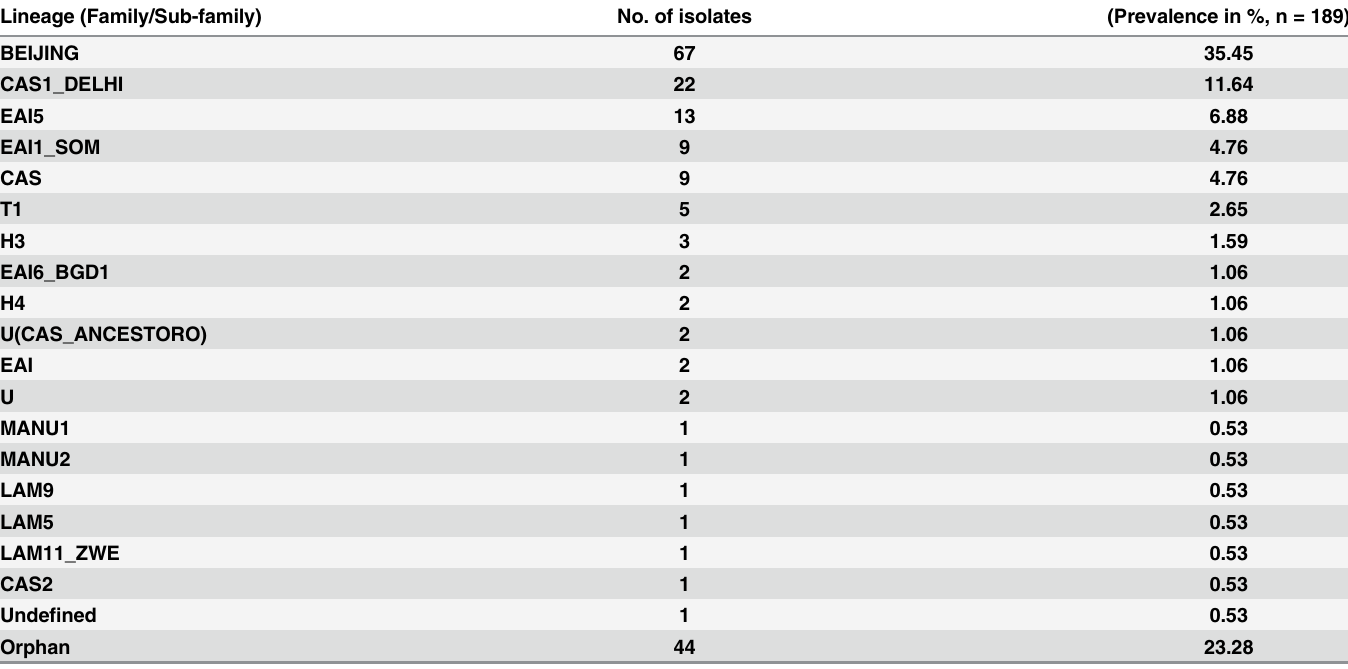
Table 1. Distribution of different lineages of MTBC Spoligotypes isolated from Assam in the study based on the classification by SITVITWEB. Lineage (Family/Sub-family)